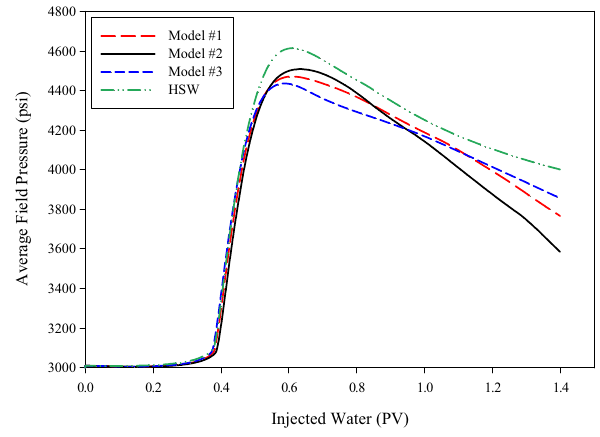
Fig. 8 Effect of salinity threshold and weighting coefficient on